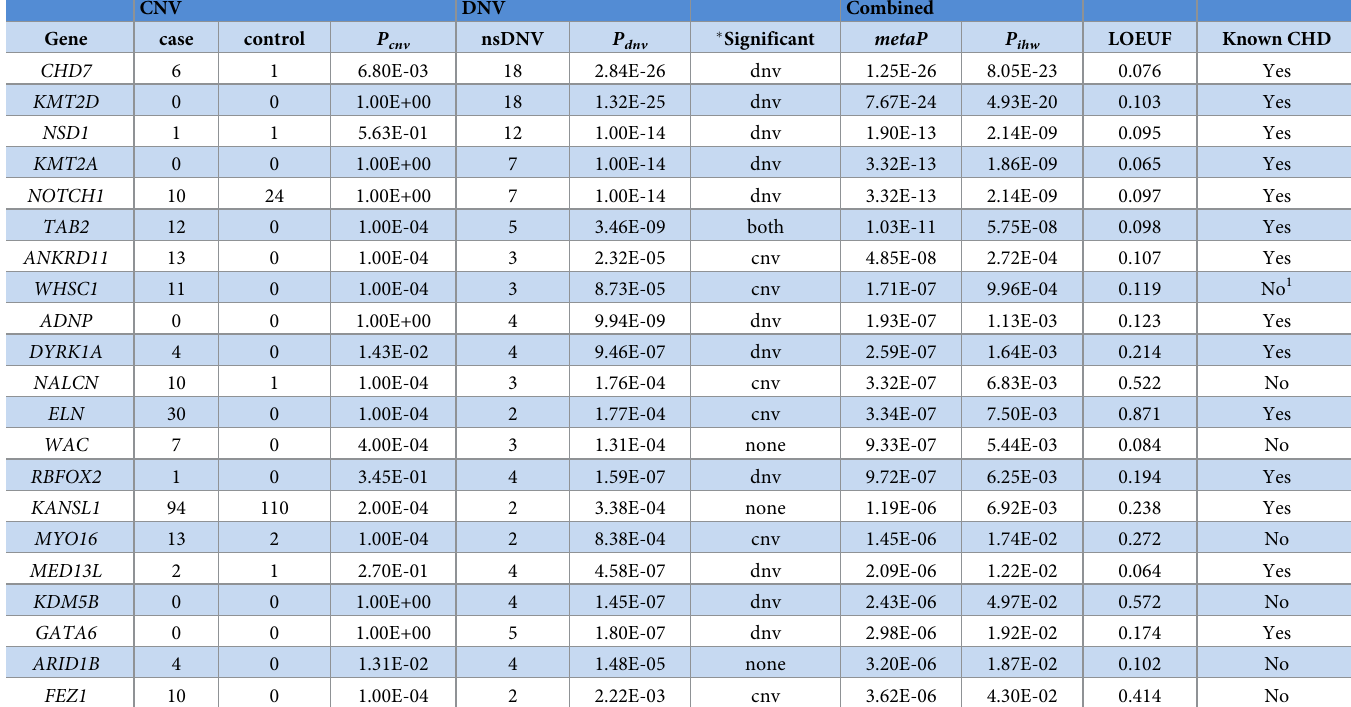
Table 1. Top 21 significant genes arising from both the permutation-based test and the DNV rate-based test. Cases/Controls: Number of cases and controls carrying CNV deletions overlapping the gene in the CNV analysis. P cnv : p-value from the CNV permutation test. nsDNV: Number of constrained non-synonymous variations in the de novo analysis. P : p-value from the DNV analysis. Significant: The analysis where the gene was significant (dnv: DNV analysis, cnv: CNV analysis, both: Both anal- dnv ysis, none: Non-significant neither DNV nor CNV analysis). metaP : combined p-value ( P dnv and P cnv ) using the Fisher method. P ihw : Bonferroni corrected p-value using independent hypothesis weighting (IHW) and LOEUF metric as covariate. LOEUF: o/e LOF ratio upper bound fraction from gnomAD. � All the 21 genes were significant after combining their p-values and applying Bonferroni correction. 1 Evidence is from mouse models